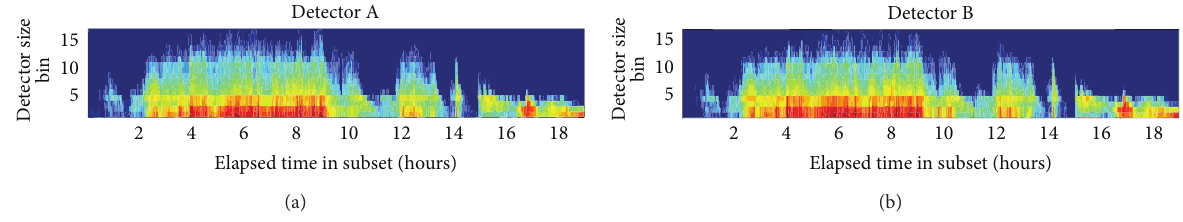
Figure 8: One-minute drop spectra for the interval discussed in Figure 6. The 𝑥 -axis displays elapsed time through the subinterval in hours; the 𝑦 -axis indicates the size bin of the associated drops. Color indicates the number of drops measured in the associated time interval (red corresponds to high concentrations; blue corresponds to low). The spectra for detectors A and B are shown, which—when analyzed in Figure 6—saw different numbers of events. Given the striking similarity of the underlying data, it seems reasonable to conclude that the spurious “tip” in detector B that prevented two separate events from being identified as one event was likely due to chance.